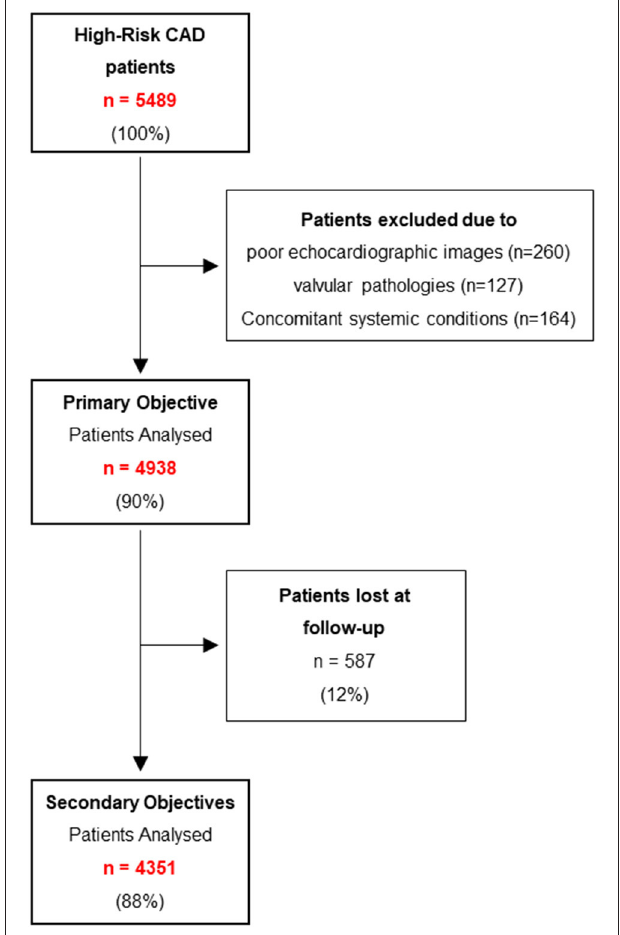
FIGURE 1 | Flow diagram of the study. CAD, coronary artery